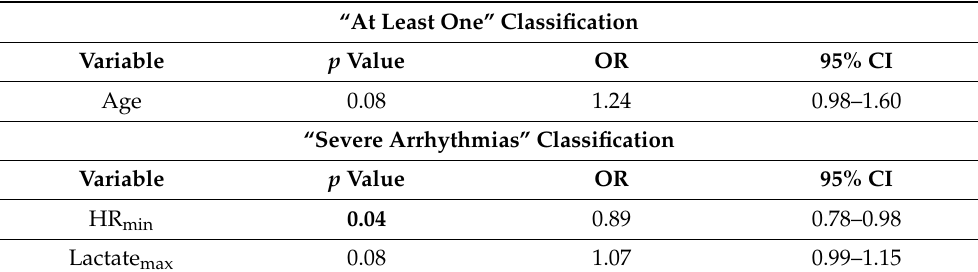
Table 5. Results of the final multiple logistic regression model referred to the “at least one” and “severe arrhythmias”